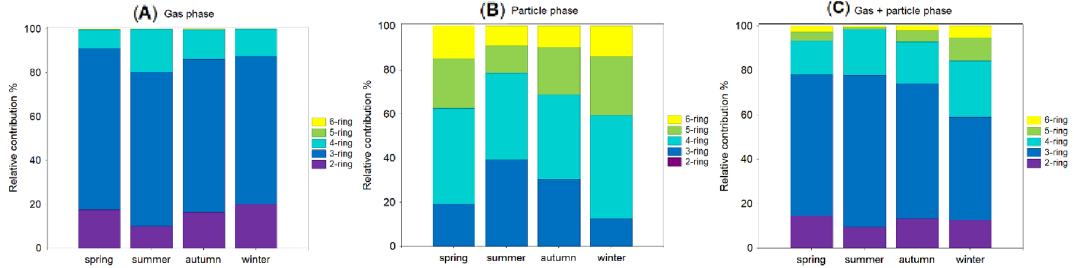
Figure 2. The relative contribution (%) of the five PAH groups (2-, 3-, 4-, 5-, and 6-ring) to the total PAHs in ( A ) the gas phase, ( B ) the particle phase, and ( C ) the gas + particle phases.